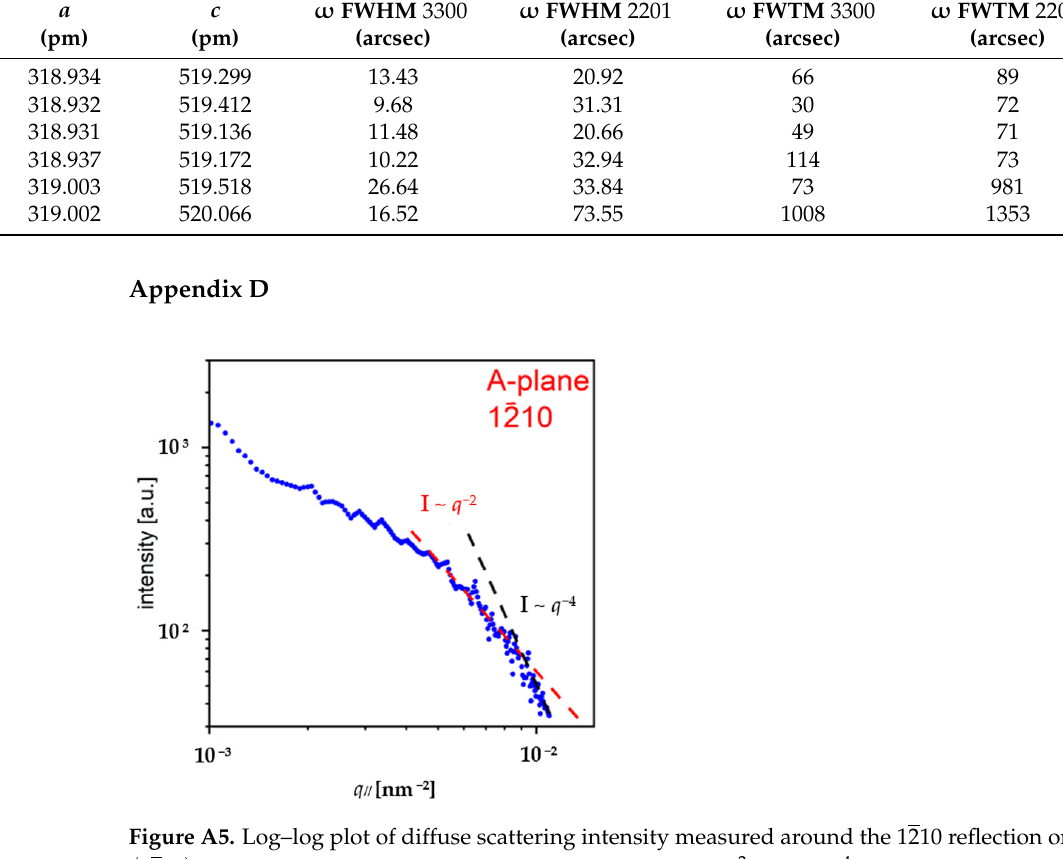
Figure A5. Log–log plot of diffuse scattering intensity measured around the 1210 reflection on the (1210) a -plane slice. The intensity decreases according to I~ q − 2 and I~ q − 4 were observed, indicating Huang and Stokes–Wilson diffuse scattering, respectively (I—X-ray intensity, q —deviation of the scattering vector H from the reciprocal lattice vector G).